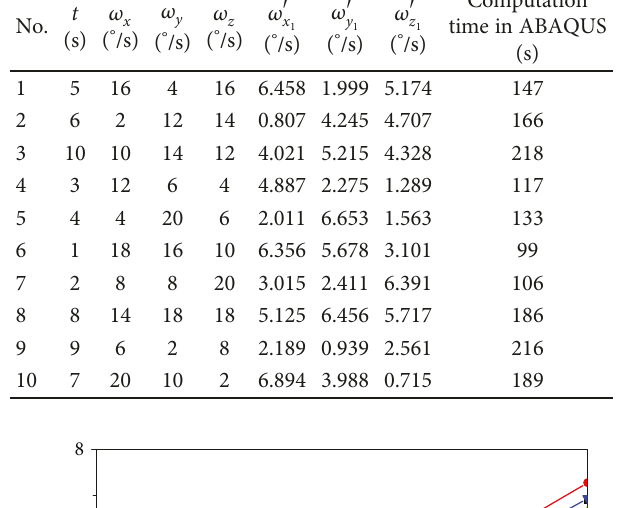
Table 5: Technical indices of attitude angular velocity for microsatellite.